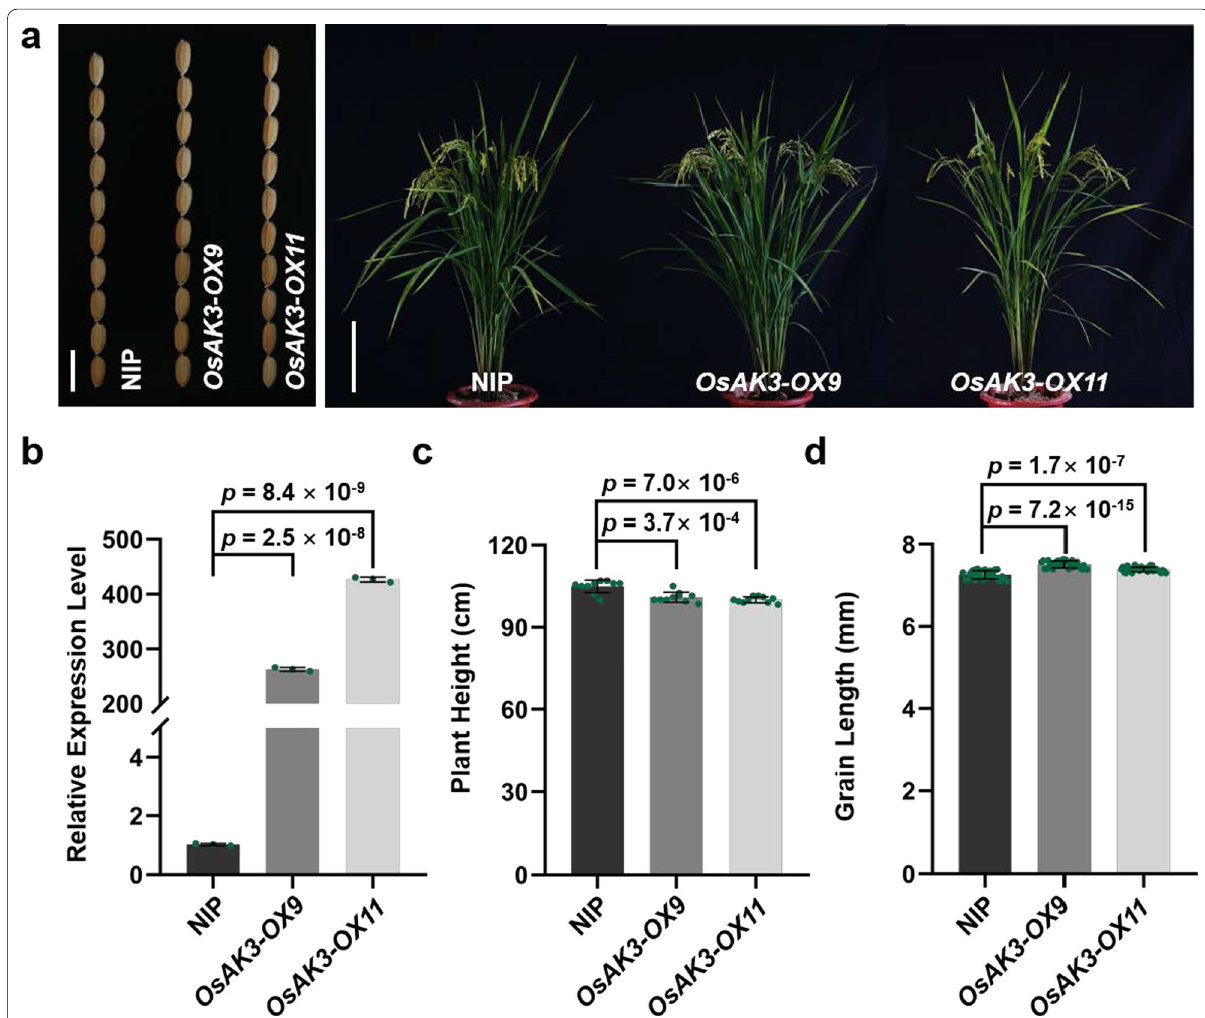
Fig. 5 Overexpression of OsAK3 increased grain length. a Plant phenotype of NIP, OsAK3-OX9 and OsAK3-OX11 at the mature stage. From left to right are grain size (scale bar, 1 cm) and plant profile (scale bar, 20 cm). b RT-qPCR analysis of OsAK3 expression in two overexpression lines. Data are means SD ( n 3). P value compared with the wild type by student’s t test. c Statistical data of plant height. Data are means ± = compared with the wild type by student’s t test. d Statistical data of grain length. Data are